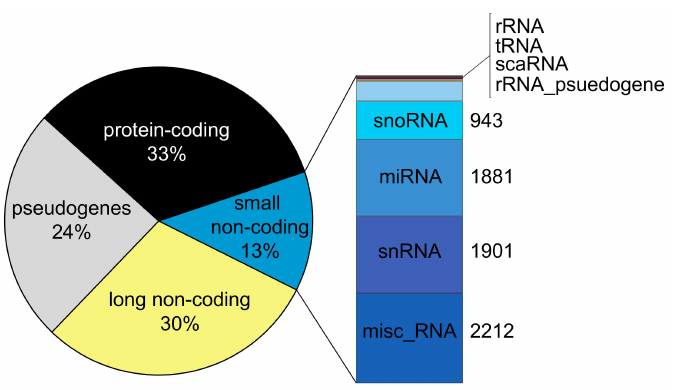
Figure 1. Diagram showing the major classes of genes contained within the human genome based on GENCODE annotation version 36 (https://www.gencodegenes.org/human/ (accessed on 6 March 2021)). The small RNA genes are composed of a variety of different biotype annotations. Shown in the stacked barplot are the small non-coding gene types, along with numbers of genes per category from the HGNC project (https://www.genenames.org/download/statistics-and-files/ (accessed on 6 March 2021)). (Abbreviations: rRNA, ribosomal RNA; tRNA, transfer RNA; scaRNA, Small Cajal body-specific RNA; snoRNA, small nucleolar RNA; miRNA, microRNA; snRNA, small nuclear RNA; misc_RNA, miscellaneous